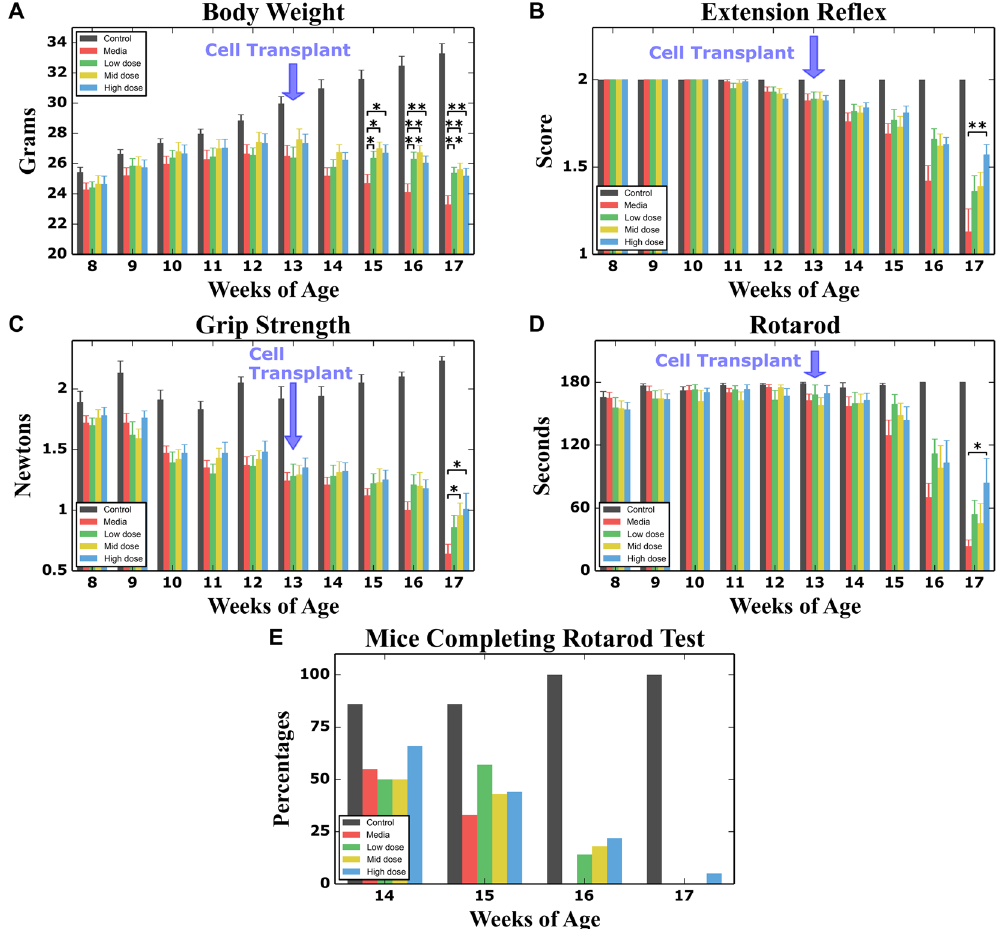
Figure 1. Characteristics of disease outcomes in symptomatic G93A mice receiving different doses of hBM34 + cells. All transplanted ALS mice during 4 wks post-treatment ( A ) significantly maintained body weight, ( B ) better extended hindlimbs, ( C ) delayed loss in muscle strength, and ( D ) stayed longer on rotarod vs. media- injected mice. More beneficial effects on motor function were determined in G93A mice treated with the 1 × 10 6 cell dose, particularly at 17 wks of age. ( E ) Percentages of ALS mice transplanted with low (5 × 10 4 cells), mid (5 × 10 5 cells), or high (1 × 10 6 cells) cell dose completing the rotarod test (180 sec) at 16 wks of age compared to 0% of media-injected mice, while at 17 wks of age, 6% of mice receiving the high cell dose were the only animals to complete this test. * p < 0.05, ** p <